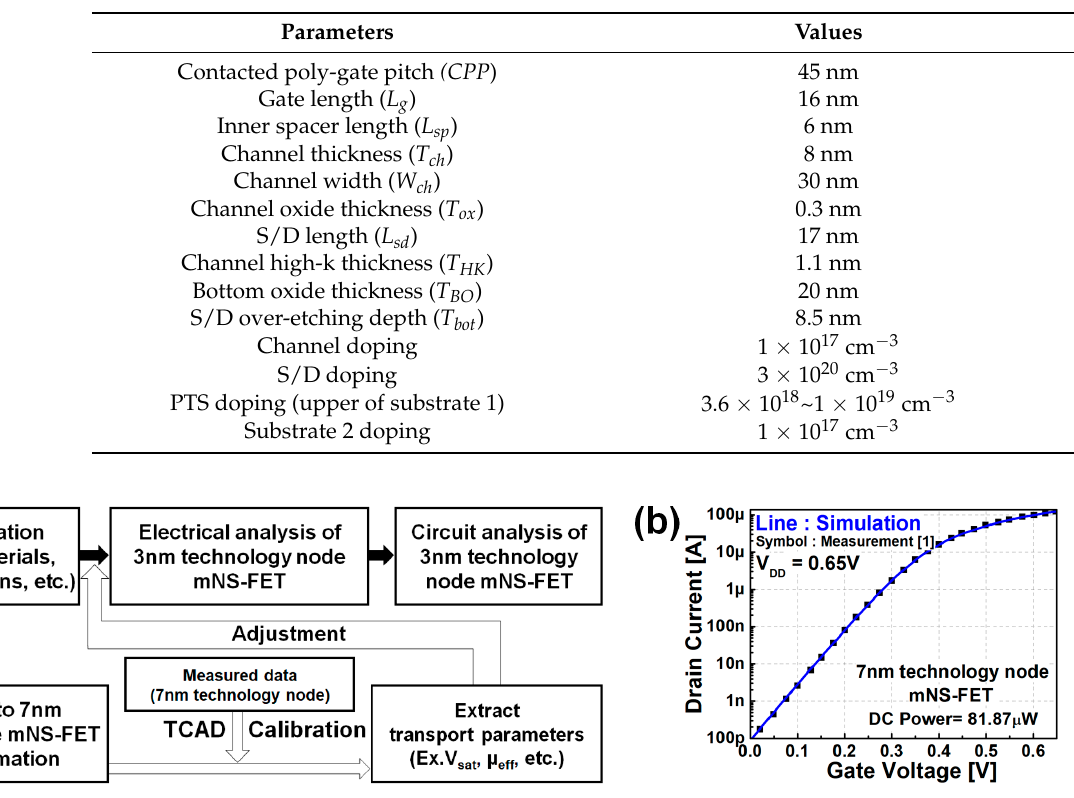
Figure 2. ( a ) Overall workflow for the analysis of mNS-FET, ( b ) I DS versus V GS calibration result based on the measurement of a fabricated mNS-FET.